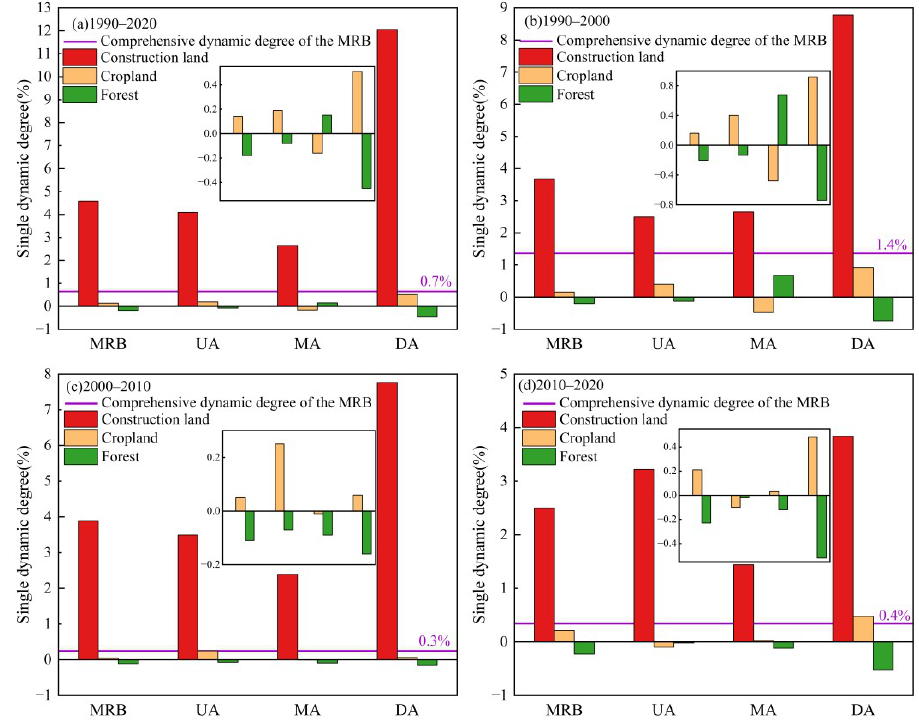
Figure 2. Dynamic degrees of land-use and land-cover changes in the Mekong River Basin (MRB) and its upstream area (UA), midstream area (MA), and downstream area (DA) during ( a ) 1990–2020, ( b ) 1990–2000, ( c ) 2000–2010, and ( d )